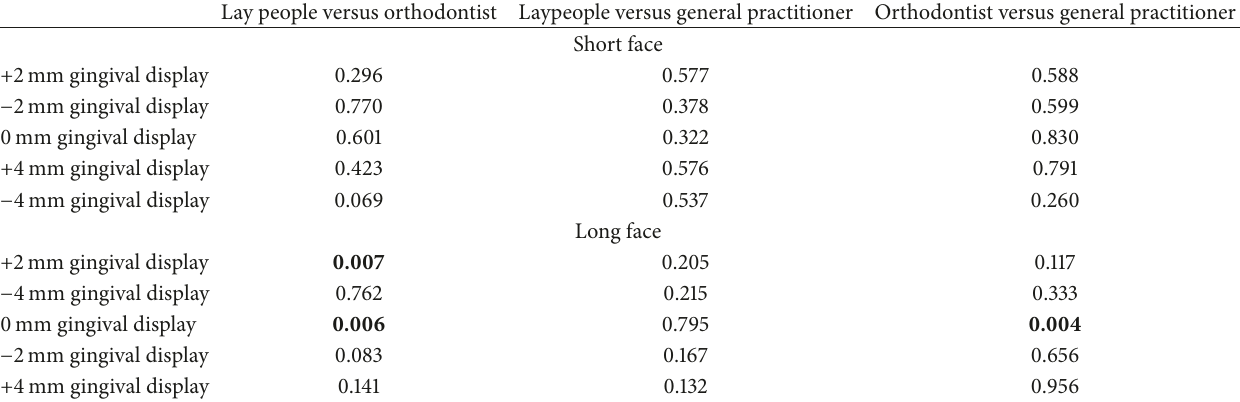
Table 4: Pairwise comparisons (Mann–Whitney U test) between the three groups of scorers for the 10 smile types. Lay people versus orthodontist Laypeople versus general practitioner Orthodontist versus general